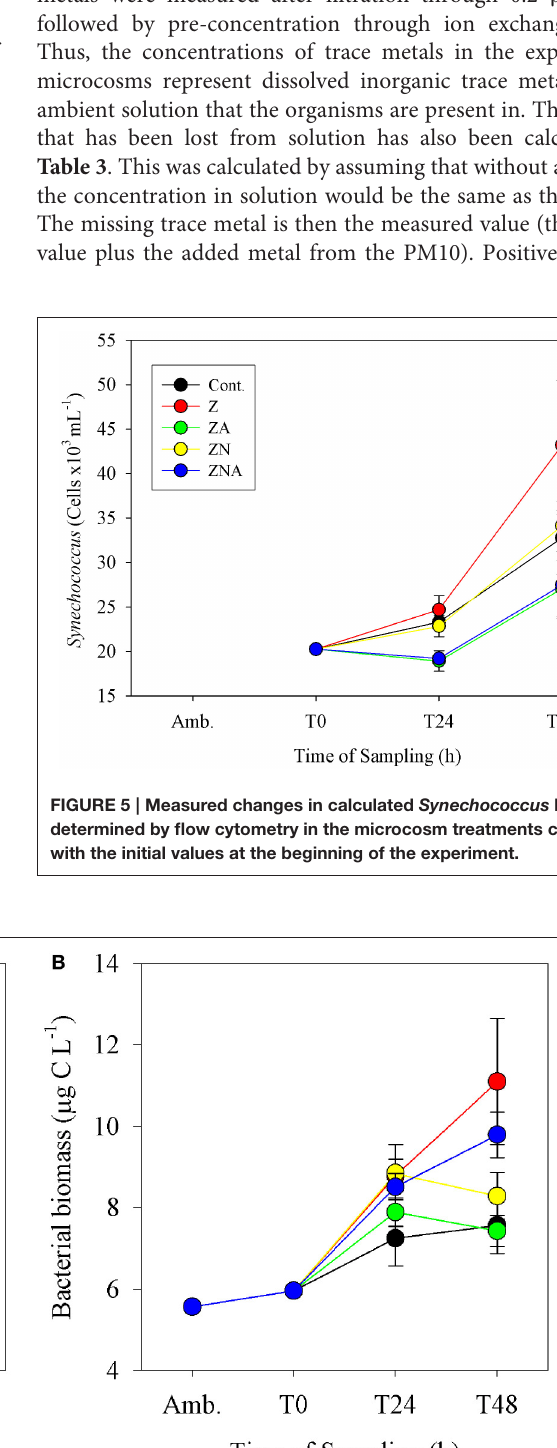
Frontiers in Marine Science |